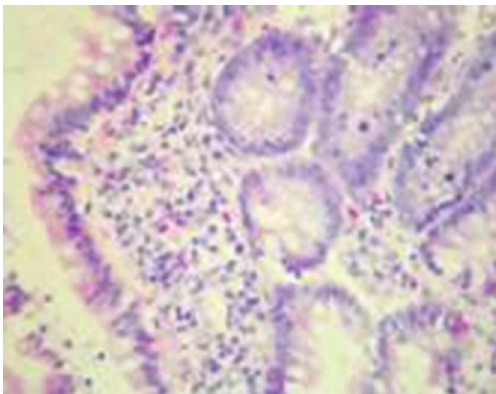
Figure 3: Model control group-28d a small quantity acidophile cells infiltration in intestinal lamina propria HE ×